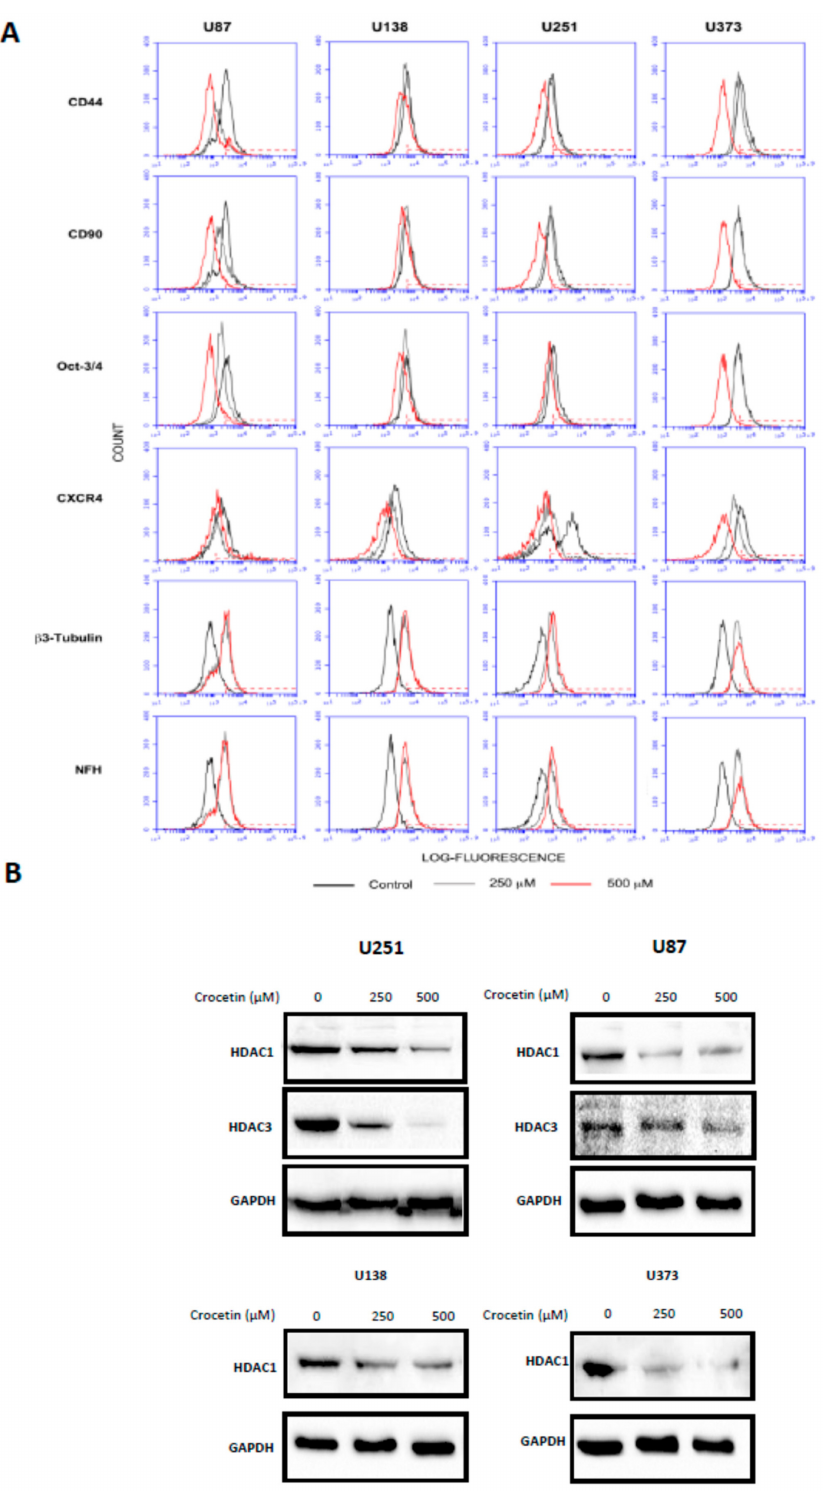
Figure 2. Crocetin reduces the levels of mesenchymal markers and induces an increase in neuronal ones in glioma cells, which could be related to histone deacetylase (HDAC) expression. ( A ) Representative Fluorescence-Activated Cell Sorter (FACS) histograms and ( B ) Western blotting analyses of HDAC1 and HDAC3 levels. Analyses was made at 72 h in cells after treatment with 250 and 500 µ M of crocetin. Cell extract samples were loaded with 20 µ g of protein per